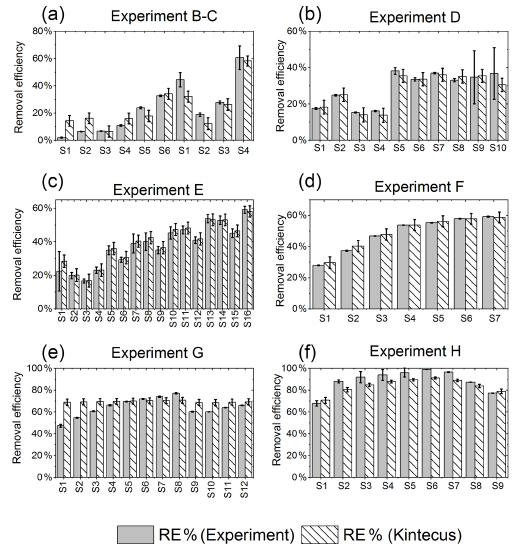
Figure E1. RE% as found experimentally (grey) and by the model (white stripes). (a) Exp. B and C, (b) exp. D, (c) exp. E, (d) exp. F, (e) exp. G, (f) exp. H.